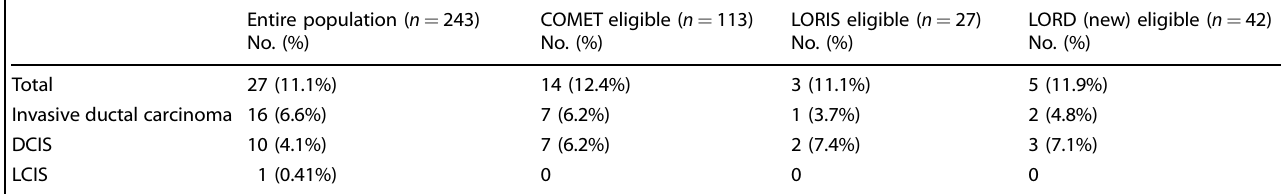
Table 4. Incidence of ipsilateral breast cancer events at least 5 years of follow-up in entire cohort and subset of trial eligible patients. Entire population ( n = 243) No. (%)